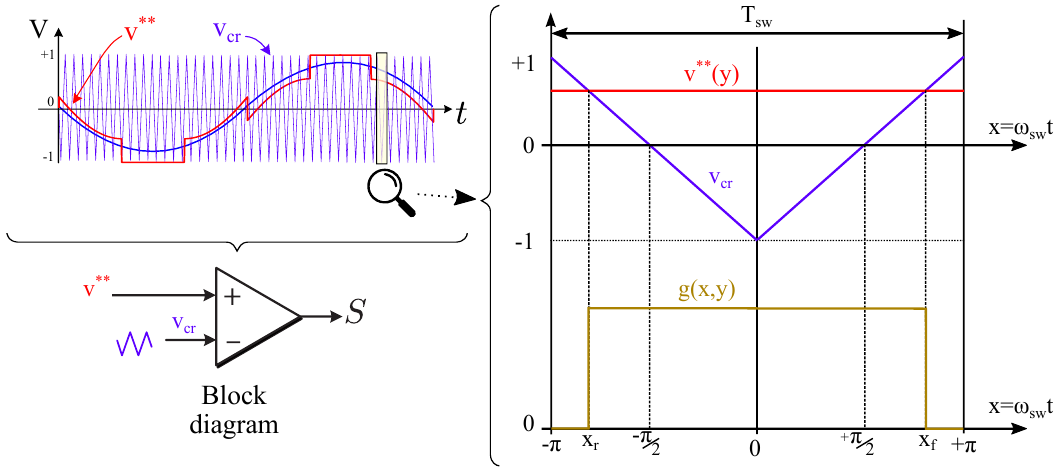
Figure 4. CB-PWM and integration limits of